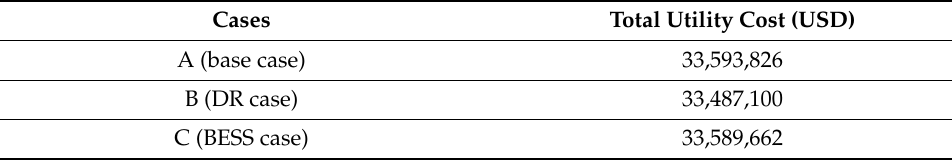
Figure 3. Single-line diagram of 14-bus distribution system. Table 2. Utility cost